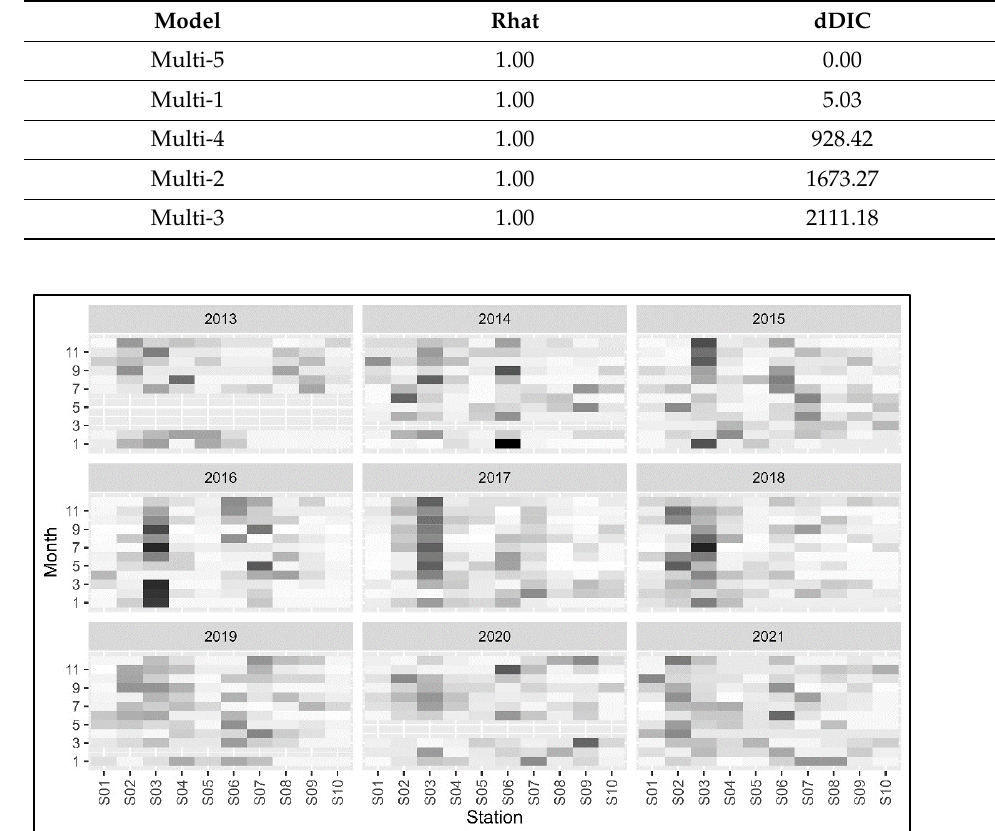
Figure 7. The mean proportions of sightings of green turtles at 10 observation stations along lower San Gabriel River, CA. Dark colors indicate higher values and vice versa.